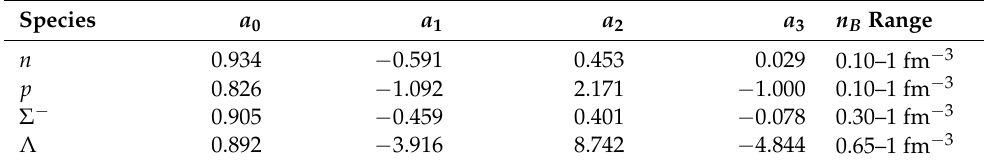
Table A2. Coefficients of the polynomial fit (A1) for NSC97a model. Last column gives the density range where the expression (A1) is valid. Notice that the a 4 coefficient is